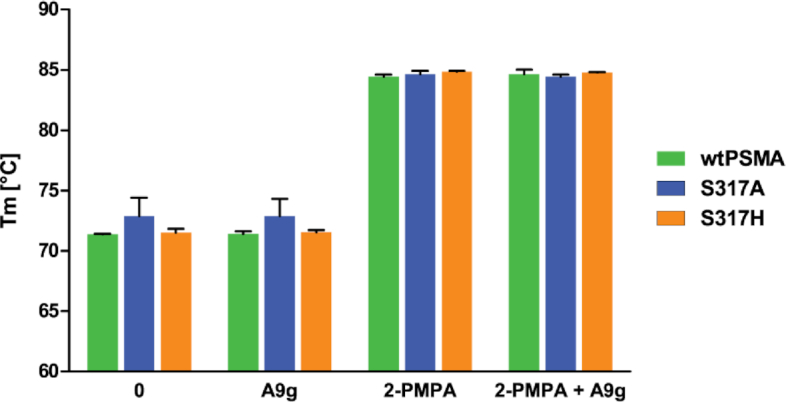
Thermostability of wtPSMA and S317 mutants using differential scanning fluorimetry (DSF). The denaturation curves of the purified extracellular part of wtPSMA and S317A and S317H mutants (1 μM) were measured for free enzymes, in the presence of 2-PMPA (10 μM), A9g (10 μM) or a mixture thereof. The melting temperatures (Tm) were determined from the inflection points of melting curves. Experiments were done in duplicate, and data are plotted as means ± standard error.